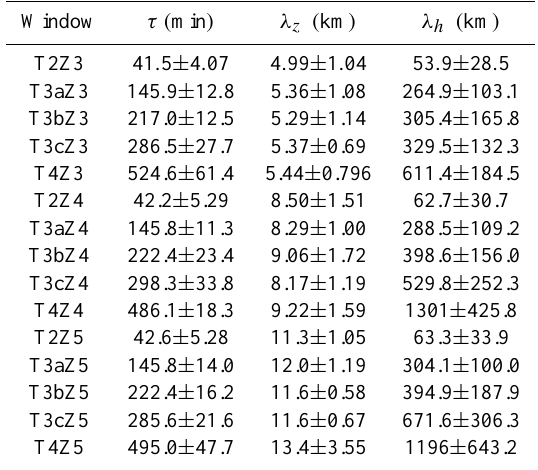
Table 4. Mean ± standard deviation of characteristic wave period τ , vertical wave length λ z , and horizontal wavelength λ h of the at- mospheric gravity wave packets with upward group velocity. The events were from winter data set.